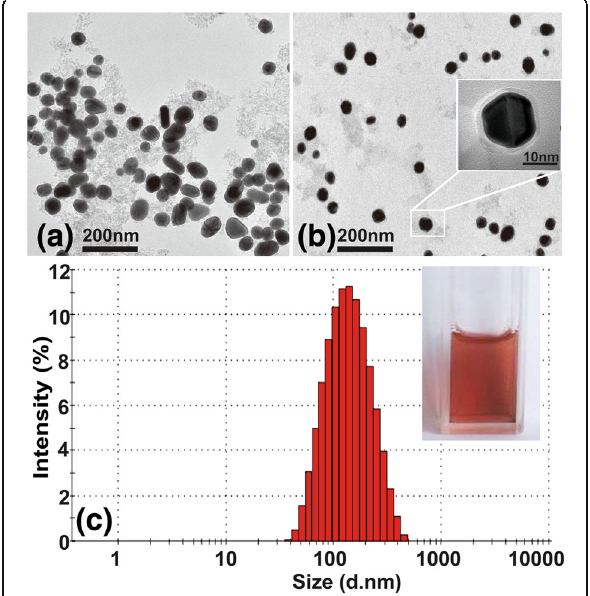
Fig. 2 a TEM images of GoldMag. b TEM images of PSS-MA-GoldMag. The inset shows particles by polymer package. c Size distribution of GoldMag and PSS-MA-GoldMag. The inset shows the photograph of PSS-MA-GoldMag solution, which is showing a red